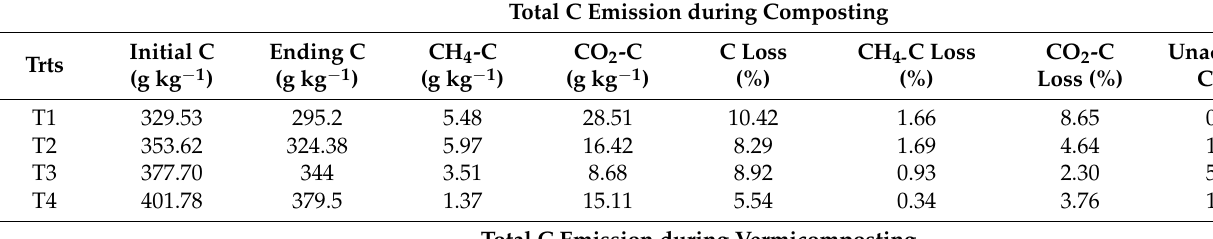
Table 4. Carbon loss (CH 4 -C and CO 2 -C) during composting and vermicomposting. Total C Emission during